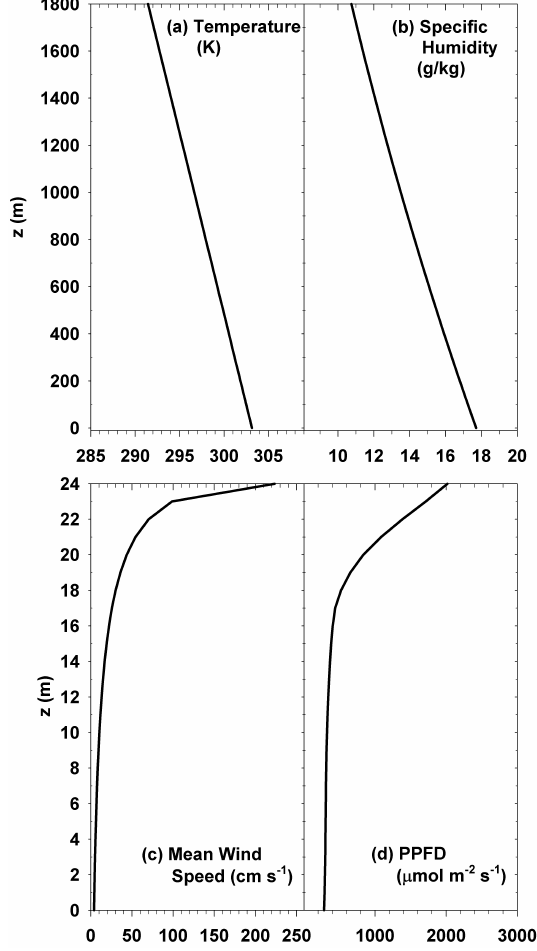
Fig. 2. Input meteorological and radiative flux data used in the Walker Branch Watershed forest canopy simulations for mid- July, 02:00p.m.LT: (a) air temperature (K); (b) specific humidity (gkg − 1 ) ; (c) mean wind speed (cms − 1 ) ; and, (d) photosynthetic photon flux density (µmolphotonsm − 2 s − 1 )